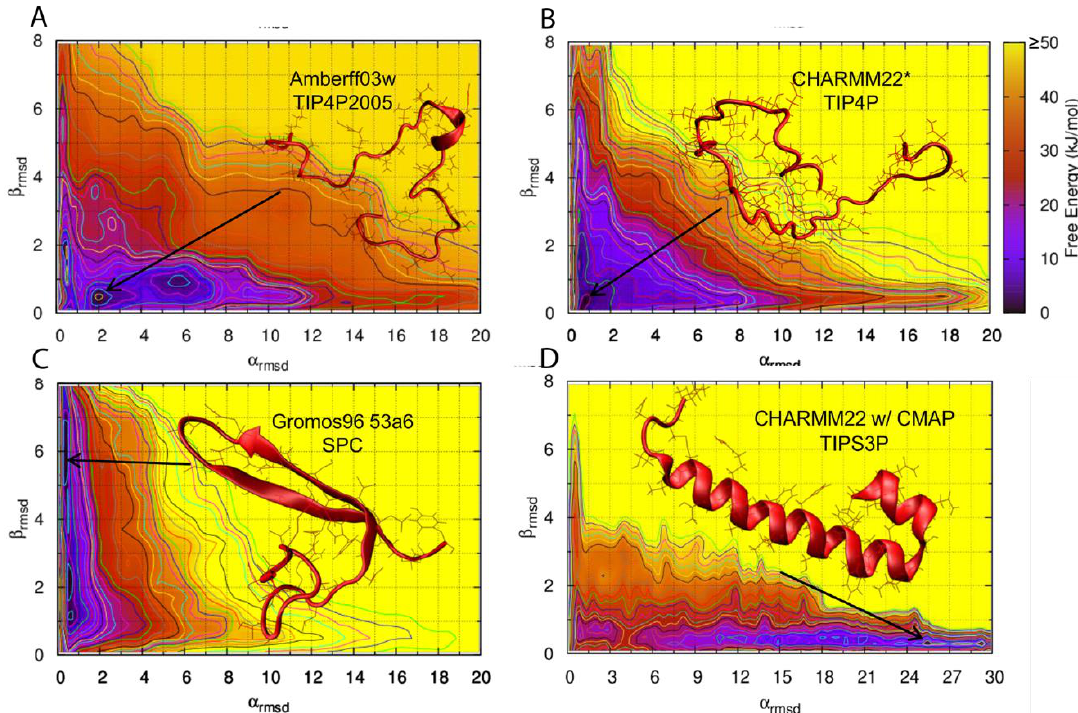
Figure 9. Conformational free energy landscape of hIAPP as a function of α -RMSD and β -RMSD for the AMBERff03w/TIP4P2005 ( A ), CHARMM22*/TIP4P ( B ), Gromos96 53a6/SPC ( C ), and CHARMM22/CMAP/TIPS3P ( D ) force fields. Adapted from Hoffmann et al. [62]. Copyright 2015 Hoffmann et al.